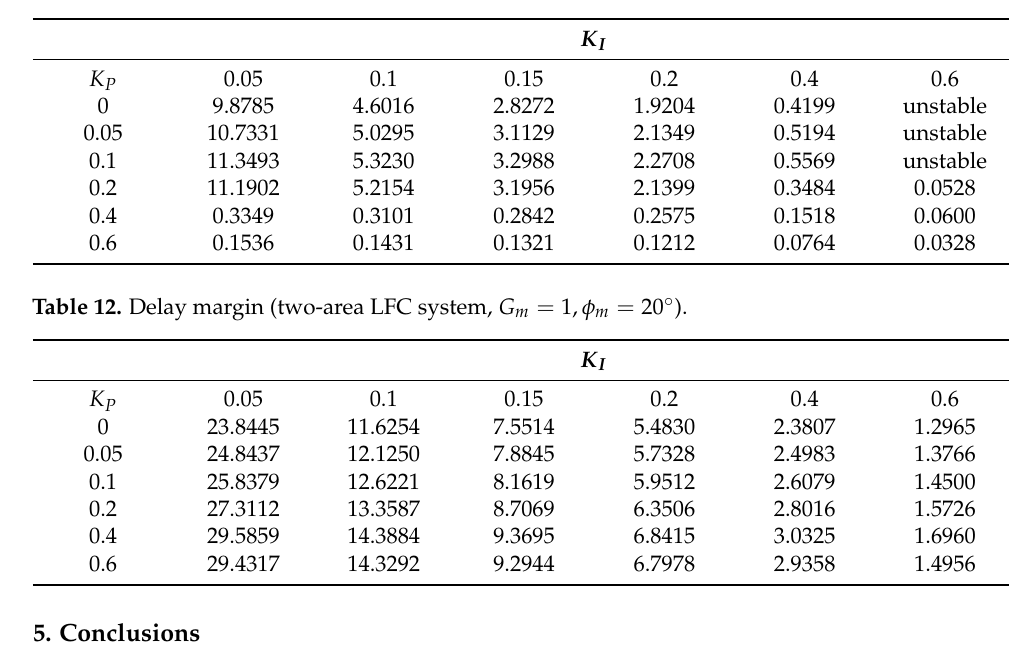
Table 11. Delay margin (two-area LFC system, G m = 3, φ m = 0 ◦ ).